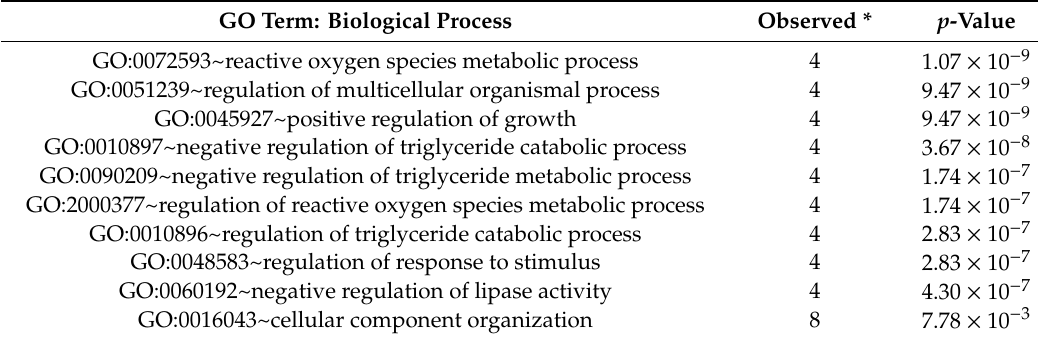
Table 6. Gene ontology (GO) enrichment analysis of the protein-coding genes co-located with the di ff erentially expressed cis-acting lncRNAs (GO level >